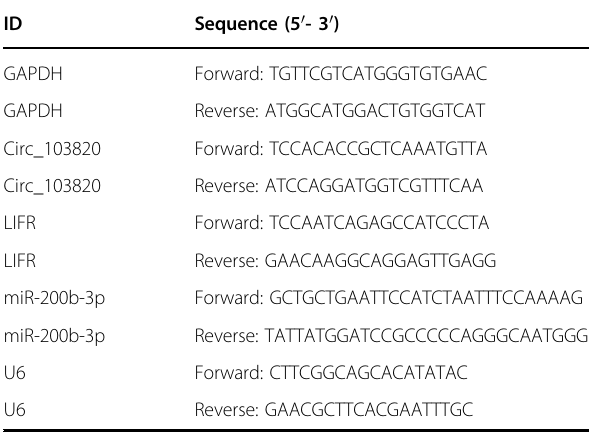
Table 4 The sequences of primers in qRT-PCR